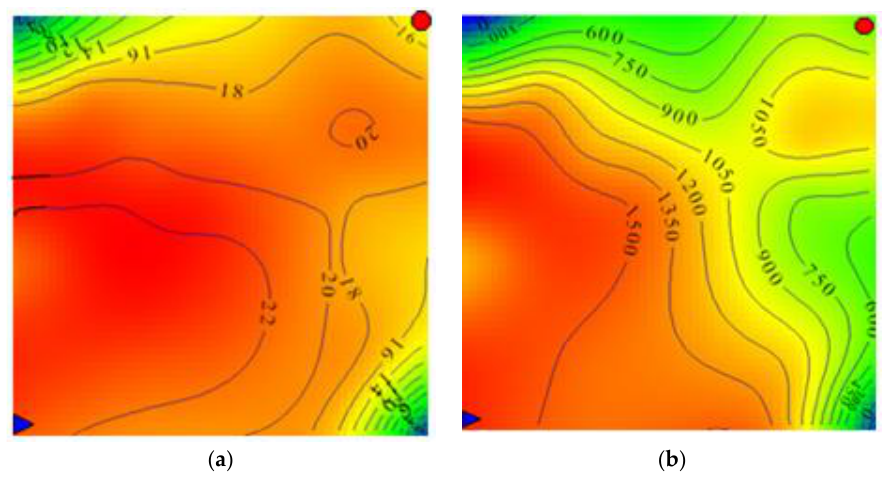
Figure 9. Viscosity and Concentration distribution after polymer flooding. ( a ) viscosity distribution; ( b ) concentration distribution